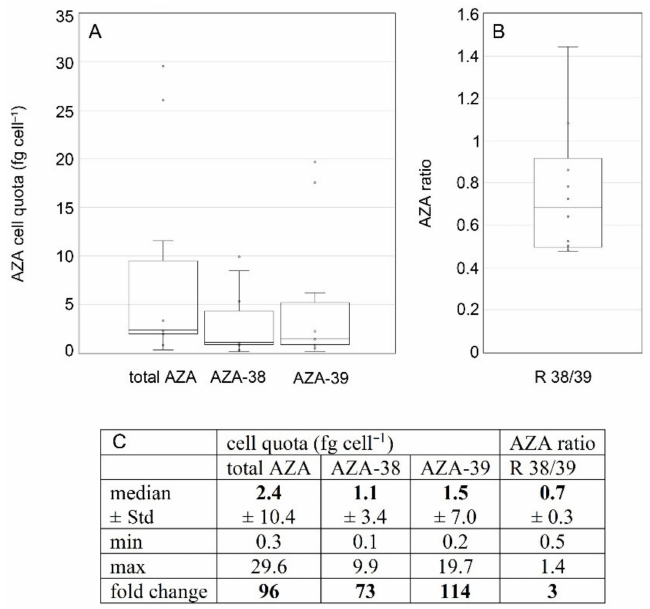
Figure 13. Amphidoma languida strains. Box-Whisker plots ( A , B ) and summary statistics ( C ) of all analyses of AZA cell quota ( A ) and AZA ratios ( B ). Std = standard